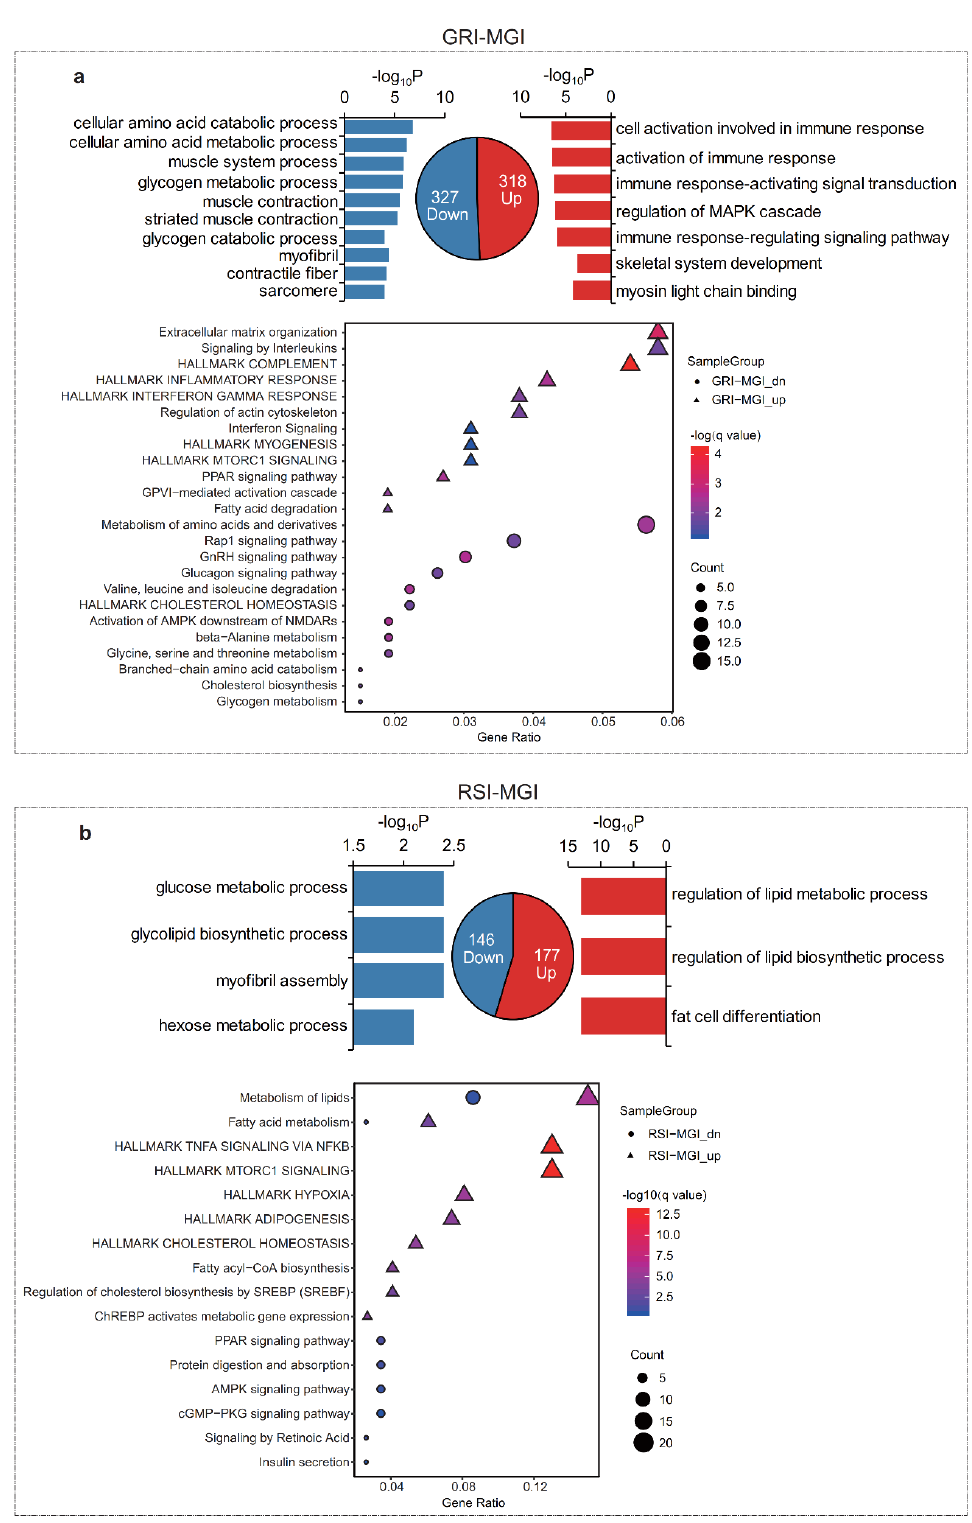
Figure 3. Gene ontology and pathway analysis of differentially expressed genes in muscle development. ( a ) Enriched GO (Gene ontology) terms (up) and Pathways (bottom) of DEGs in GRI vs. MGI group. ( b ) Enriched GO terms (up) and Pathways (bottom) of DEGs in RSI vs. MGI group. Directly up-regulated (red) and down-regulated (blue) gene numbers and ontologies are shown. Abbreviations: MGI, the inflection point with the maximum growth rate; GRI, the inflection of the gradually increasing stage to the rapidly increasing stage; RSI, the inflection point of the rapidly increasing stage to the slowly increasing stage.